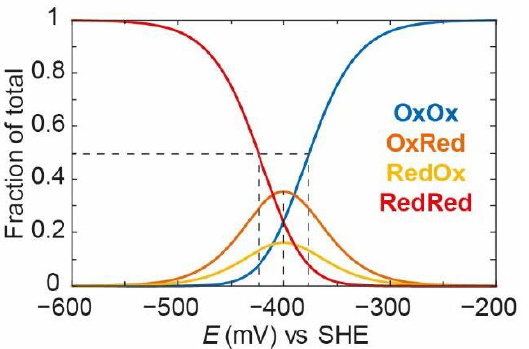
Figure 11. Variation of the fraction (out of 1) of the oxidised ( OxOx , blue), partially reduced ( OxRed , dark orange, RedOx , light orange) and fully reduced ( RedRed , red) species as a function of the ap- plied potential. The curves were obtained using Equations (29)–(32), with E O E O = E O = − 410 mV (i.e., no redox anti-cooperativity), giving an average E O of − 400 mV, for com- 2 3 parison with earlier